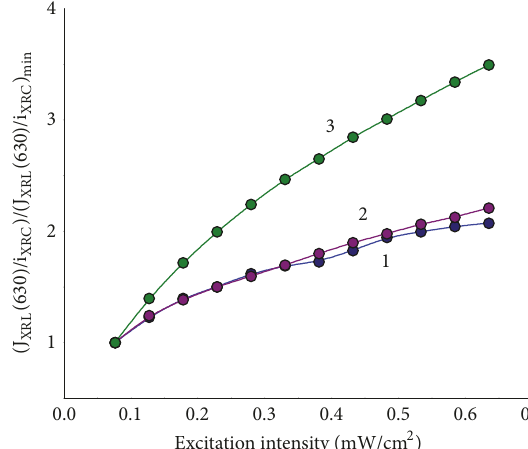
Figure 9: Normalized dependencies of the ratio of the intensity of the XRL 630 nm band to the X-ray conductivity current on the excitation intensity at temperatures: 8 K (1) , 85 K (2) , and 295 K (3)